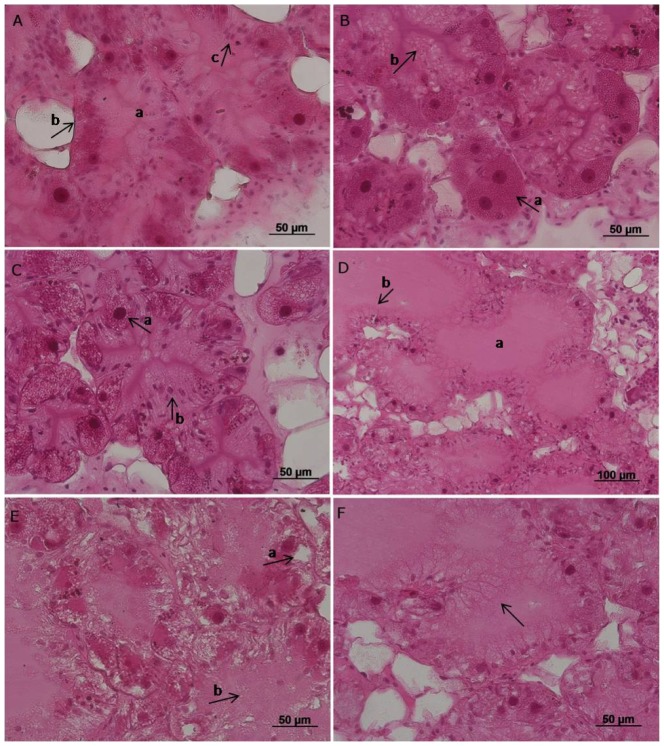
Digestive gland of Xeropicta derbentina in different reaction states.
A. Digestive gland of a control animal. a. indicates tight lumina, b. a smooth base of the tubule and c. shows an oval-shaped nucleus and regular vacuolization of the digestive cells. B. Digestive gland of a control animal. a. shows a calcium cell with dense cytoplasm and round nucleus. b. indicates an irregular vacuolization of the digestive cells with partially fused vacuoles. C. Digestive gland in state of reaction. a. indicates dark nuclei and an irregular cytoplasm of the calcium cells. Also hypertrophy of the calcium cells occurs. D. Digestive gland in state of reaction. a. shows enlarged lumina of the tubule and b. shows pronounced and ruptured apices of the digestive cells. E. Digestive gland in state of destruction. a. indicates a very irregular cytoplasm with bright spots in the calcium cells. b. shows cell fragments in the lumen of the tubule. Cell borders are disengaged. F. Digestive gland in state of destruction showing necrosis. The arrow indicates ruptured cell apices. Cell borders are disengaged.